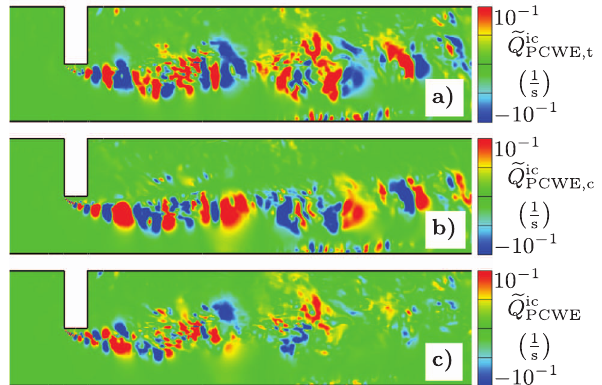
Figure 9. Contours of the PCWE source term and its compo- nents for case C 1.